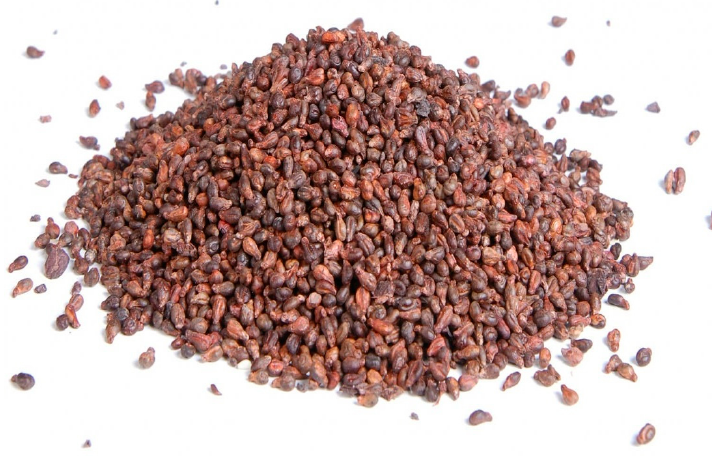
Figure 5. Image of grape seed. Source: [102].